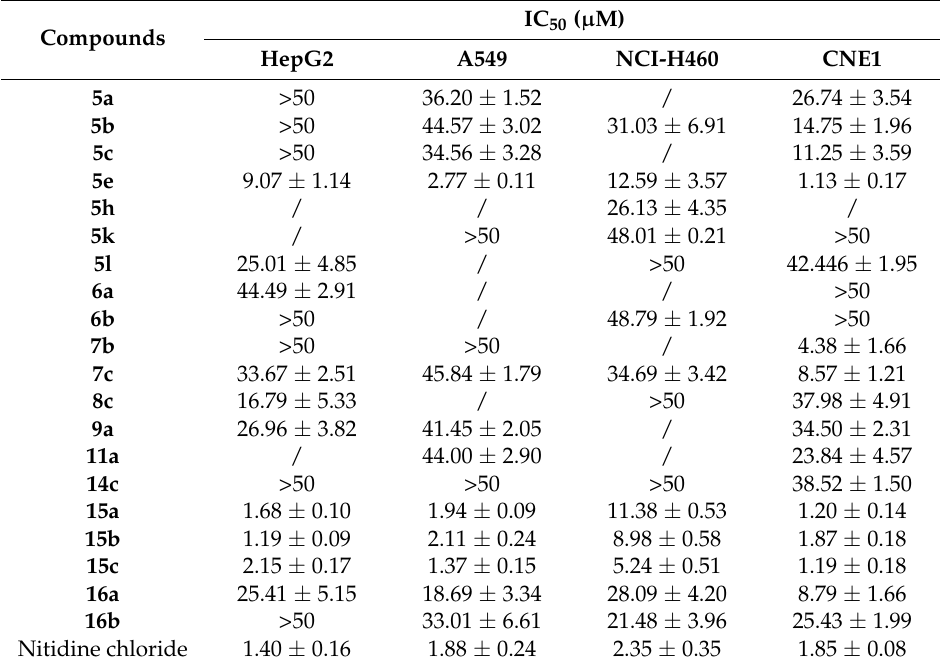
Table 1. Antitumor activity of some